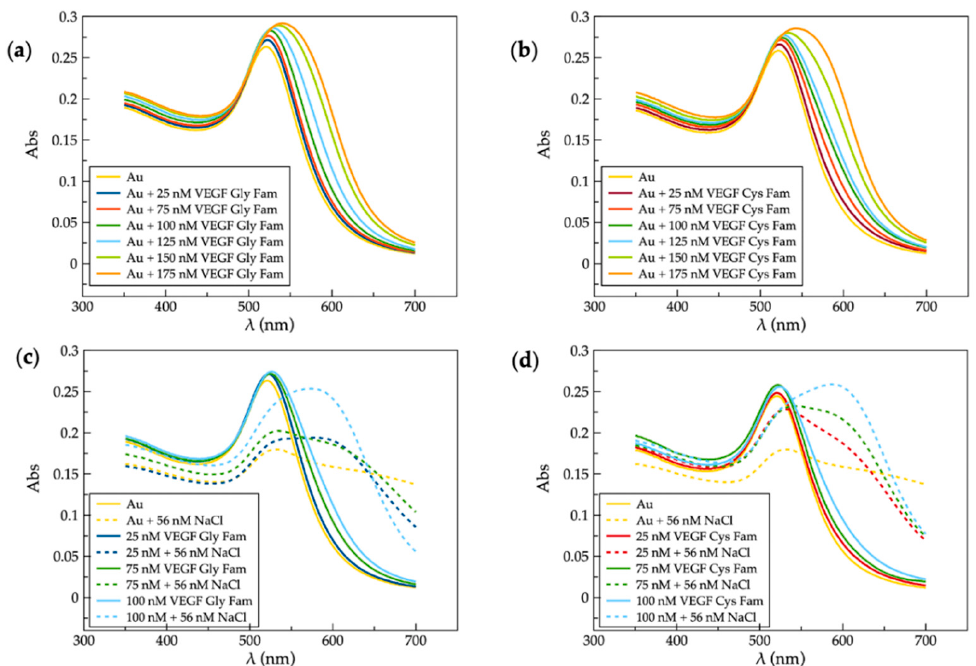
Figure 1. Changes in the AuNP (1.3 nM) plasmonic band by addition of: VEGF Gly FAM ( a ) and VEGF Cys FAM ( b ) at increasing concentrations (from 2.5 × 10 − 8 M to 17.5 × 10 − 8 M). In ( c , d ) are shown the UV-visible spectra of bare and peptide-coated AuNPs upon the addition of 56 µM NaCl.